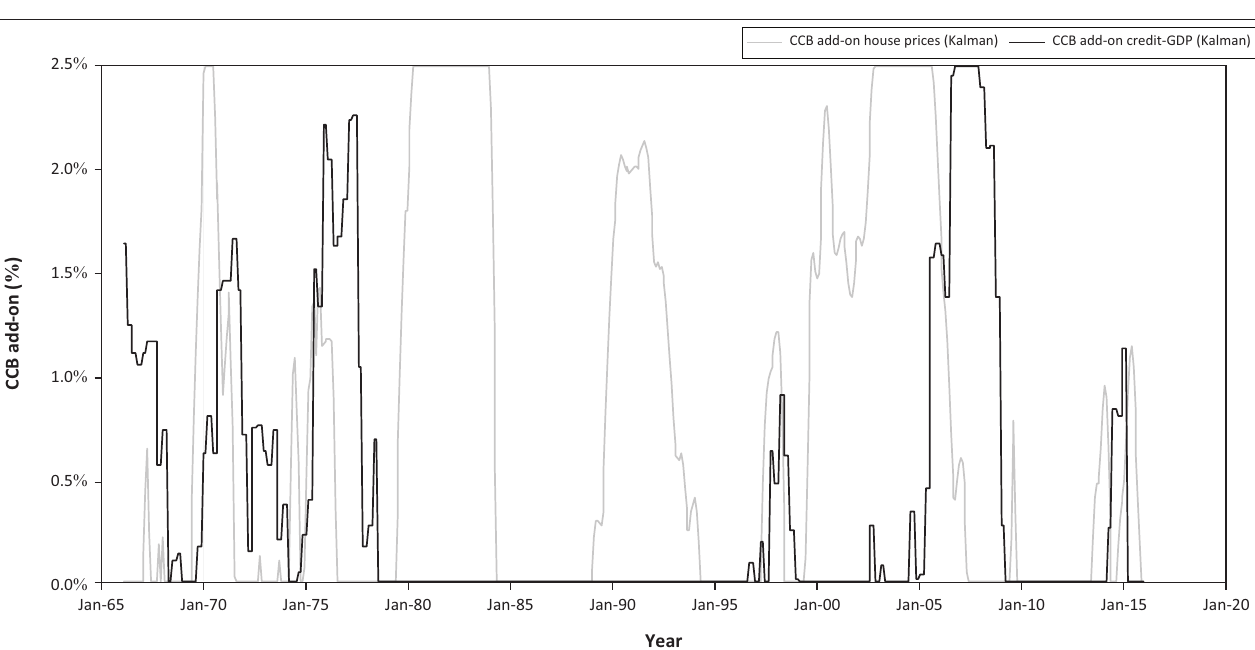
FIGURE 9: Countercyclical Capital Buffer capital charge add-on for credit-to-GDP and housing index series using the Kalman filter.